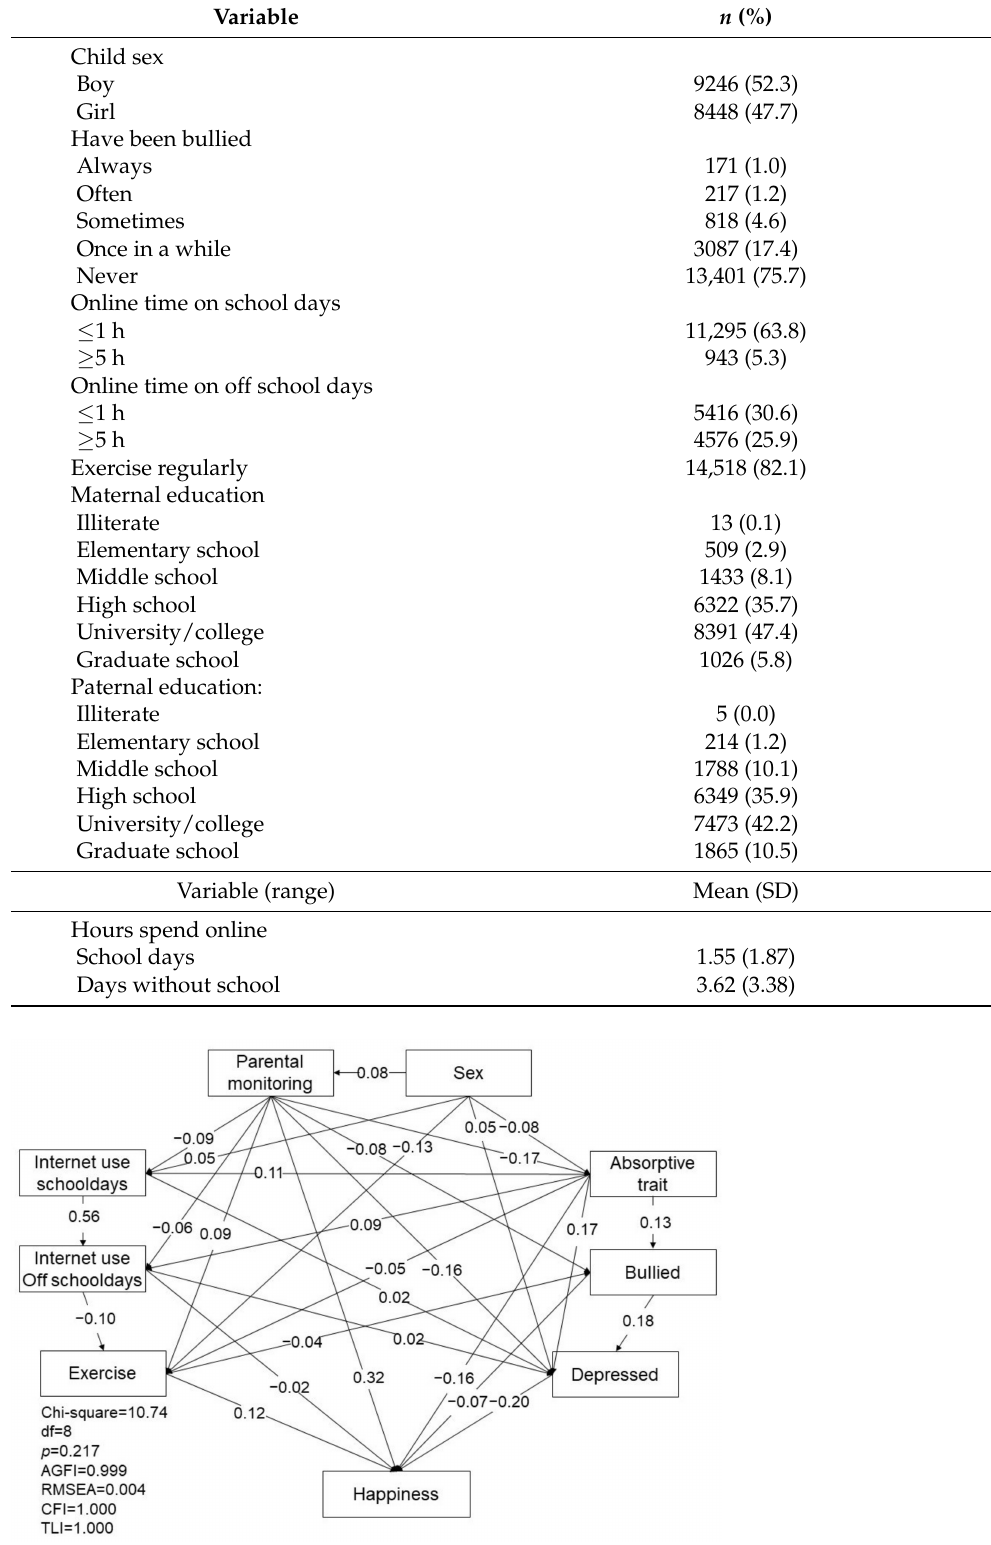
Table 1. Demographic distribution of the adolescents and parents ( n = 17,694).